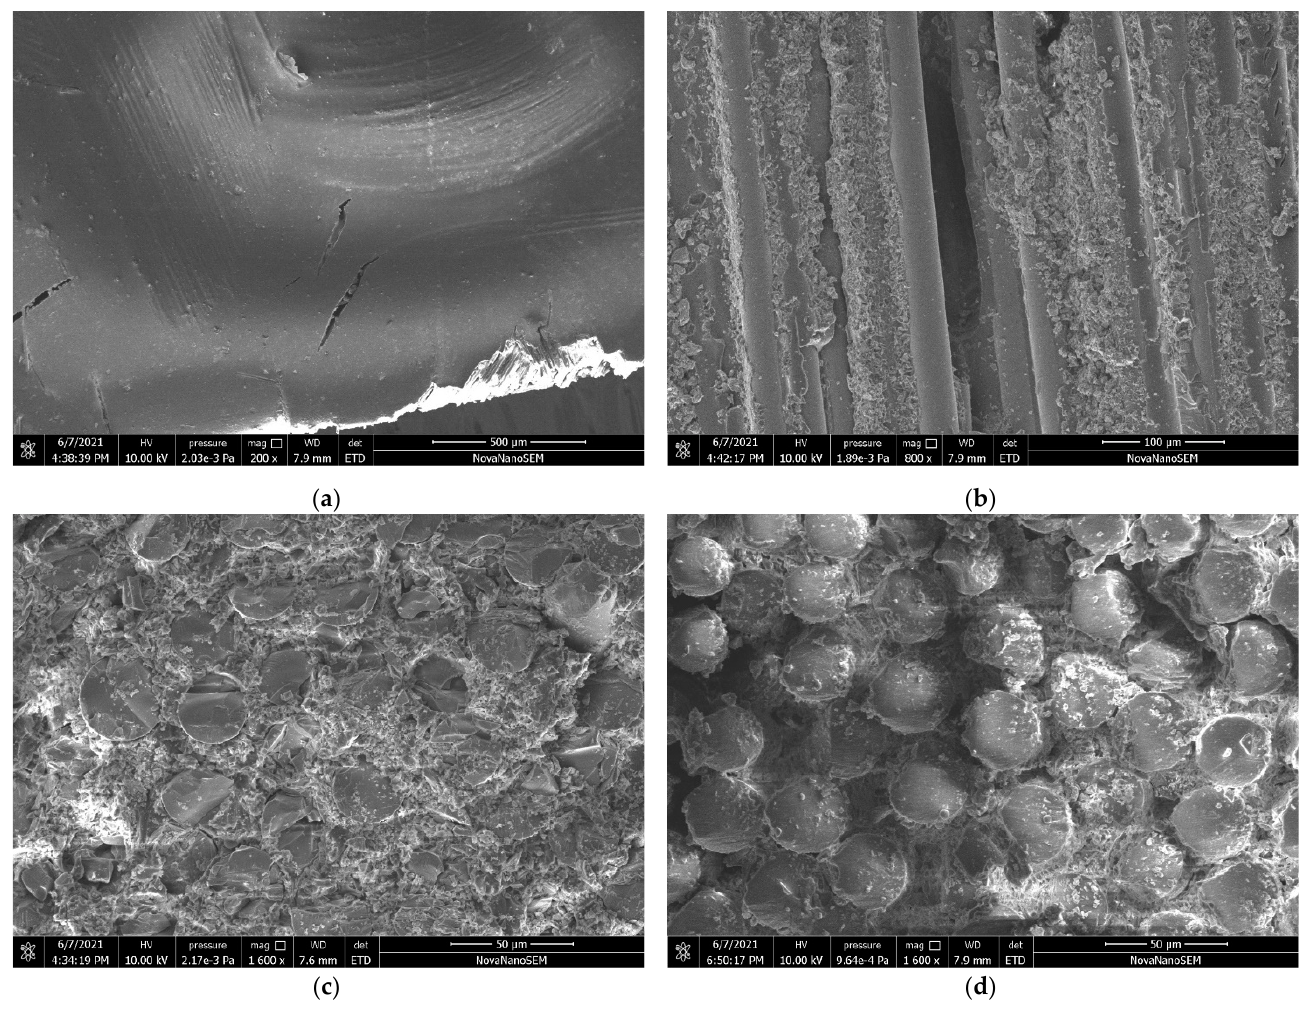
Figure 2. The SEM images of internal fiber structure: ( a ) The laminated surface (magnification 200×); ( b ) Longitudinal fiber view (magnification 800×); ( c , d ) Images normal to the pultrusion direction (magnification 1600×).